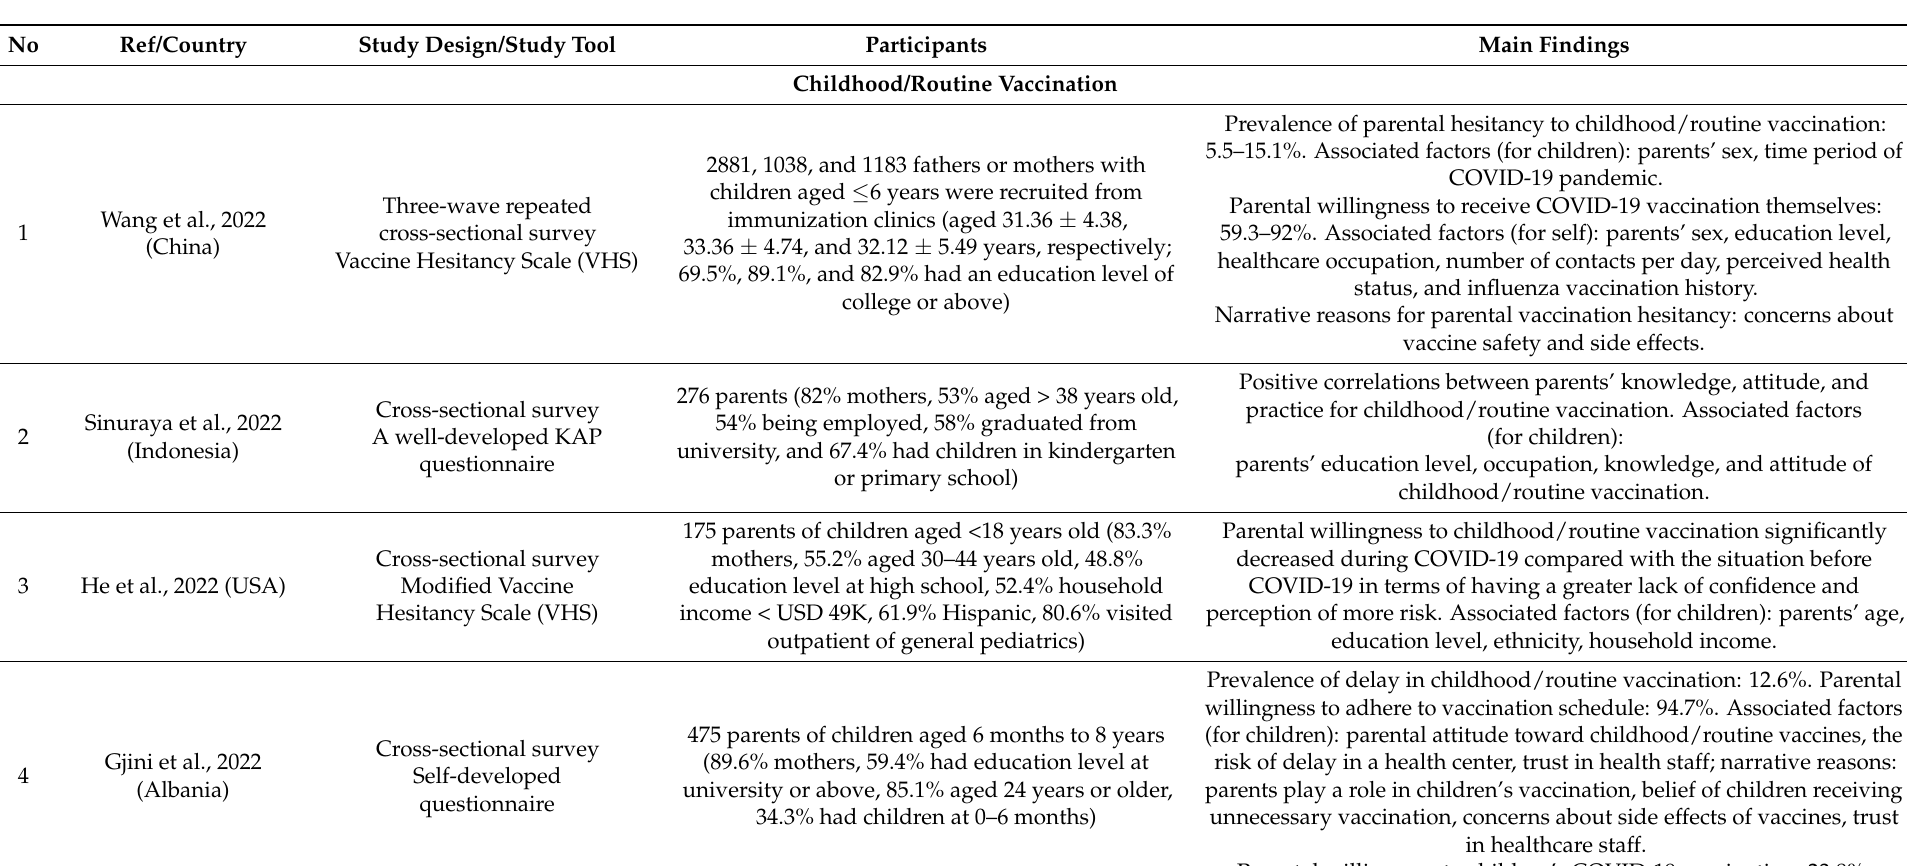
Table 1. Basic information of included